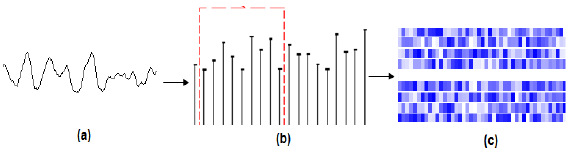
Figure 12. Distribution of share positive/negative energy. (a) the signal of gesture has been digitized. (b) The modified signal STFT using Hamming window. (c) The distribution of the energy of negative/positive energy around the threshold when motions are shown colored boxes with value increases from white to dark blue